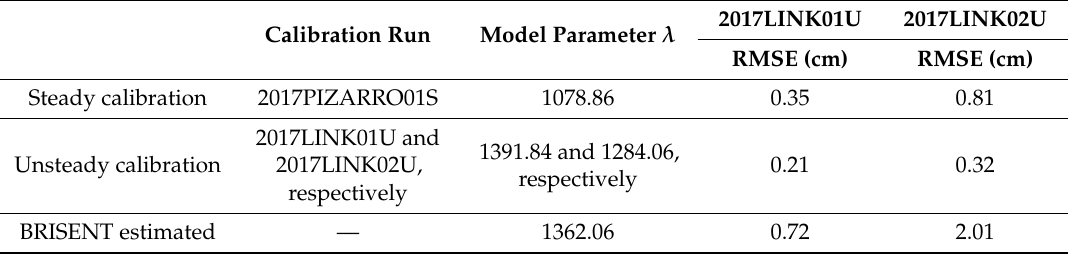
Table 5. Summary of model benchmarking in terms of